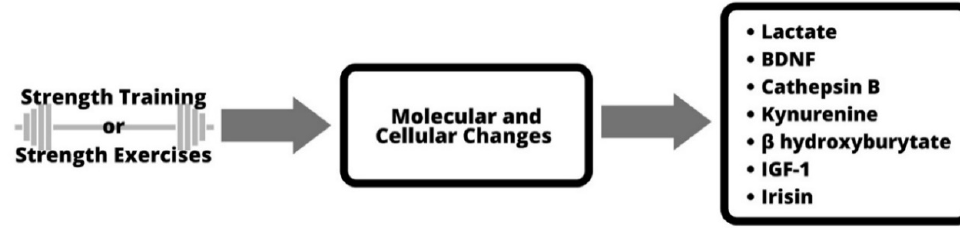
Figure 1. Molecular and cellular mechanisms of strength training.